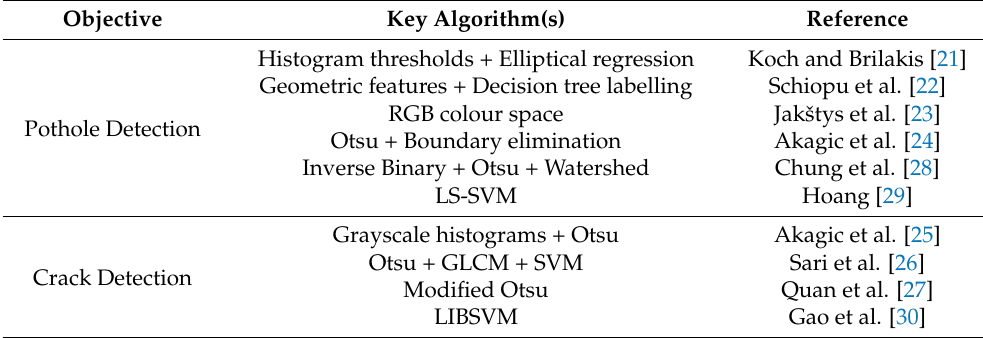
Table 1. Summary of road damage detection papers in traditional image processing.